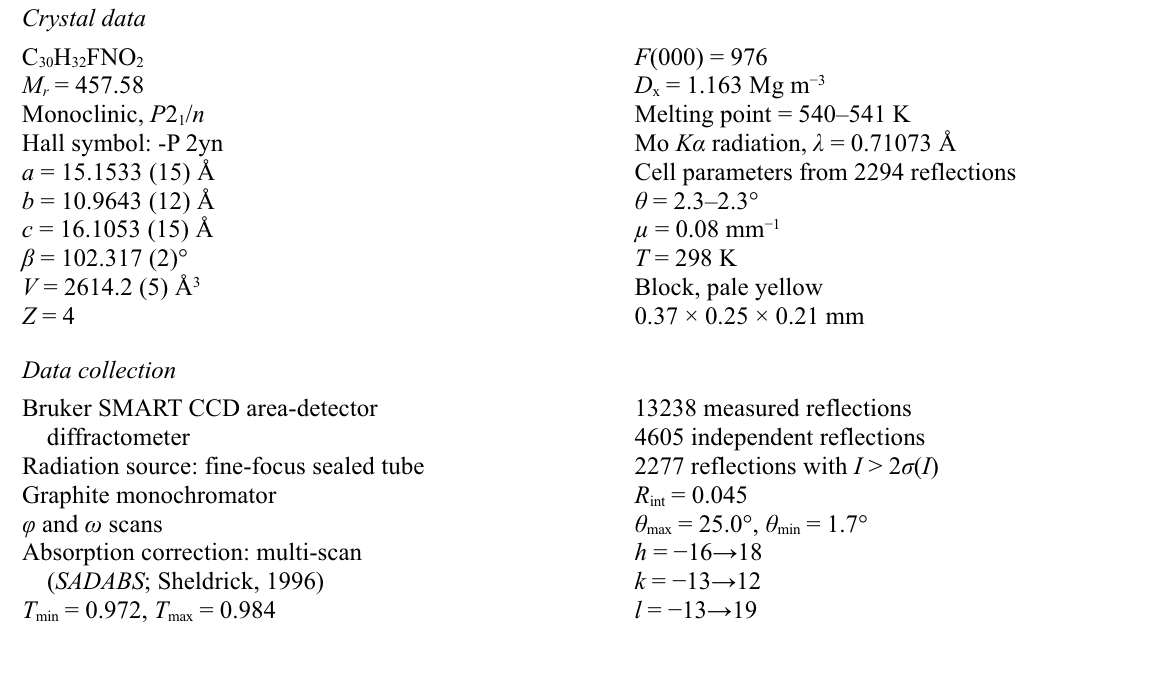
A partial packing diagram of the title compound. Hydrogen bonds are shown as dashed lines. 9-(4-Fluorophenyl)-3,3,6,6-tetramethyl-10- p -tolyl-1,2,3,4,5,6,7,8,9,10-